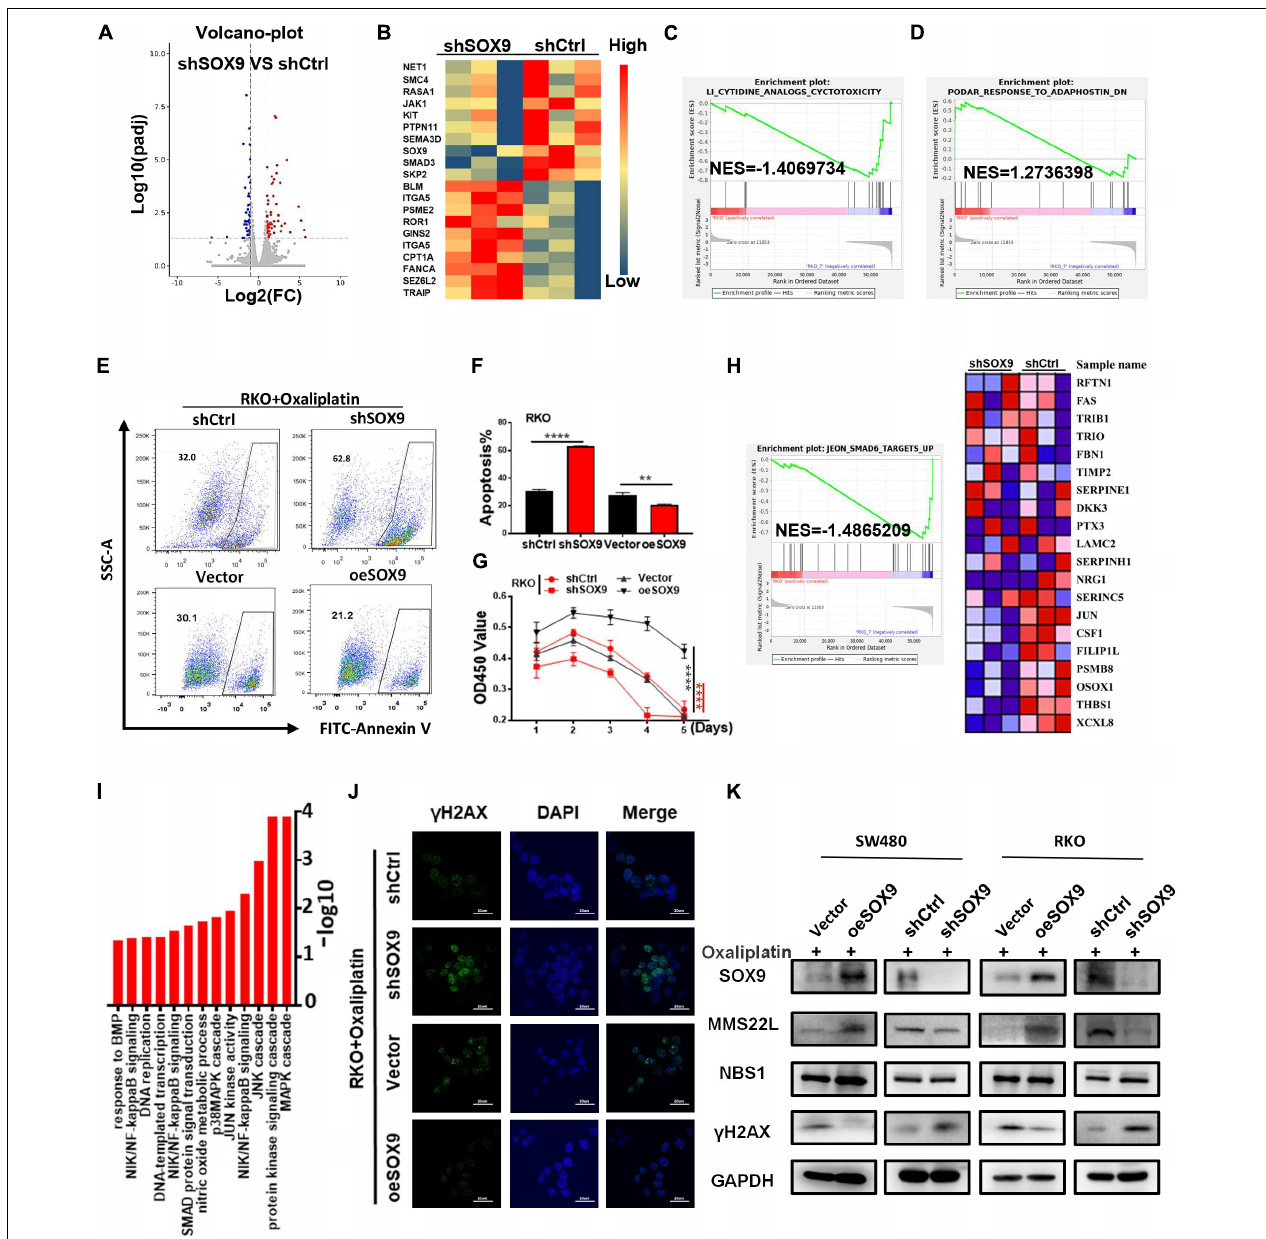
FIGURE 2 | High expression of SOX9 promotes oxaliplatin resistance by inducing DNA repair in CRC cells. (A) Volcano plot showing the change in gene expression levels in shSOX9 RKO cells compared to control cells. (B) Heatmap showing the change in chemosensitivity and chemoresistance genes in shSOX9 RKO cells compared to control cells. (C,D) GSEA of drug sensitivity genes altered by SOX9 knockdown. (E,F) Representative images (E) and numbers (F) of early apoptotic shSOX9 and oeSOX9 CRC cells compared to control cells. (G) Cytotoxicity assay showing the proliferation of oeSOX9 and shSOX9 CRC cells treated with oxaliplatin compared to control cells. (H) GSEA of genes related to DNA damage altered by SOX9 knockdown in CRC cells. (I) Pathway enrichment analysis showing that the pathways related to DNA damage in shSOX9 CRC cells were extremely different from those in control cells. (J) Immunofluorescence showing representative images of γ H2AX (green) in oeSOX9 and shSOX9 CRC cells treated with oxaliplatin compared to control cells. Nuclei were stained with DAPI (blue) (scale bar = 20 µ m). (K) Western blotting was used to detect the expression of MMS22L, NBS1, and γ H2AX in oeSOX9 and shSOX9 CRC cells treated with oxaliplatin compared to control cells. ** p < 0.01; *** p < 0.001; and **** p <